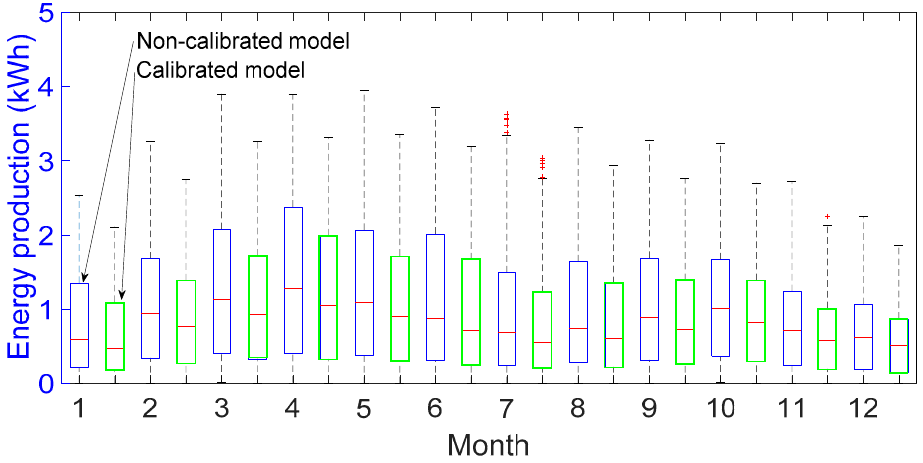
Figure 12. Monthly power generation differences between calibrated and noncalibrated models. Table 5. Difference in BIPV energy production between calibrated and noncalibrated models. Energy Production